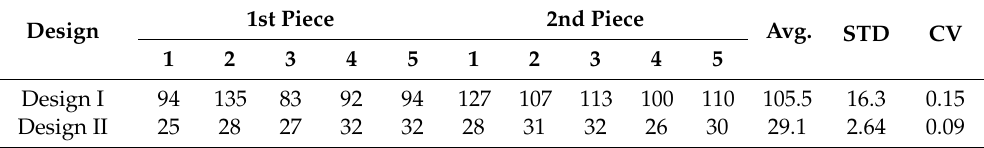
Table 2. Uniformity in lens height of MLAs (Unit: μm) Design